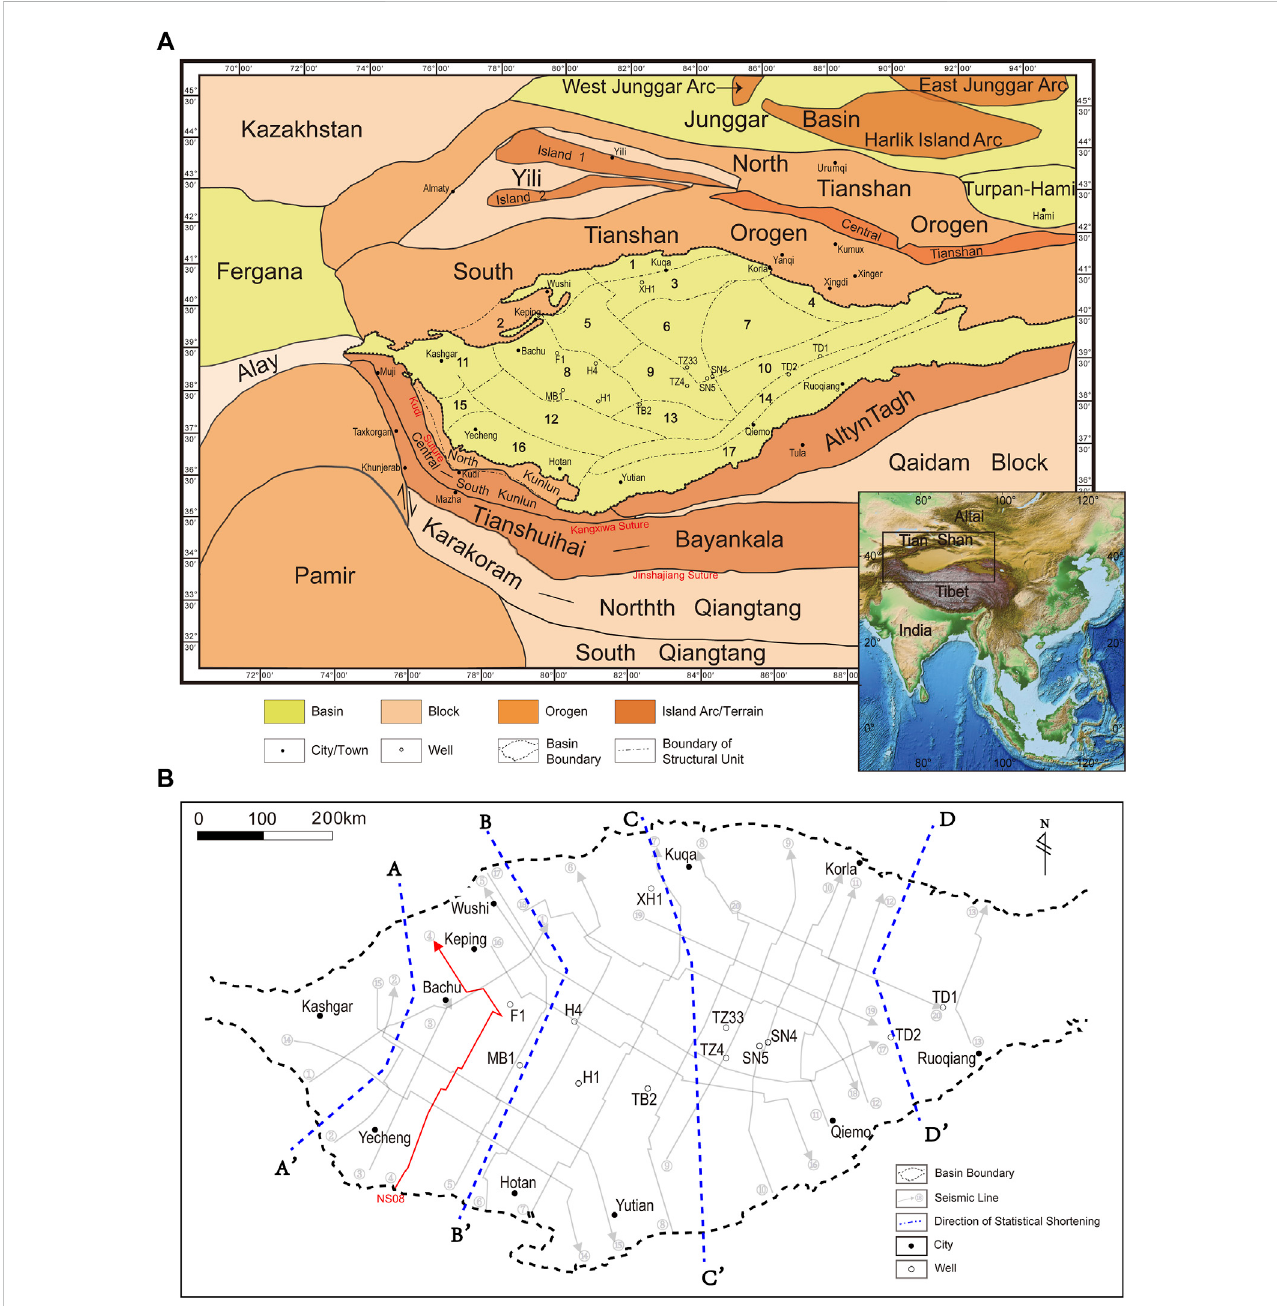
FIGURE 1 Schematic structural maps of the Tarim basin and adjacent areas, and location of the study area. (A) Schematic structural map of the Tarim basin and adjacent areas (modi fi ed after He et al., 2016); Structural units of Tarim basin: 1-Kuqa Depression; 2-Kalpin Faulted Uplift; 3-Tabei Uplift; 4-Kongque River Slope;5-AwatiDepression;6-ShuntuoguoleUplift;7-ManjiaerDepression;8-BachuUplift;9-Tazhong Uplift;10-GuchengxuUplift;11-KashiDepression;12- Maigaiti Slope; 13-Tangguzibas Depression; 14-Tanan Uplift; 15-Shache Bulge; 16-Yecheng Depression; 17-Southeast Depression. (B) Location of 20 basin-scale seismic sections used to calculate shortening. These shortening data are integrated on four representative lines (AA ’ , BB ’ , CC ’ , and DD ’ ) (cf. Laborde et al., 2019). The seismic section NS08 and the balanced cross-section recovered from it are shown in Figure